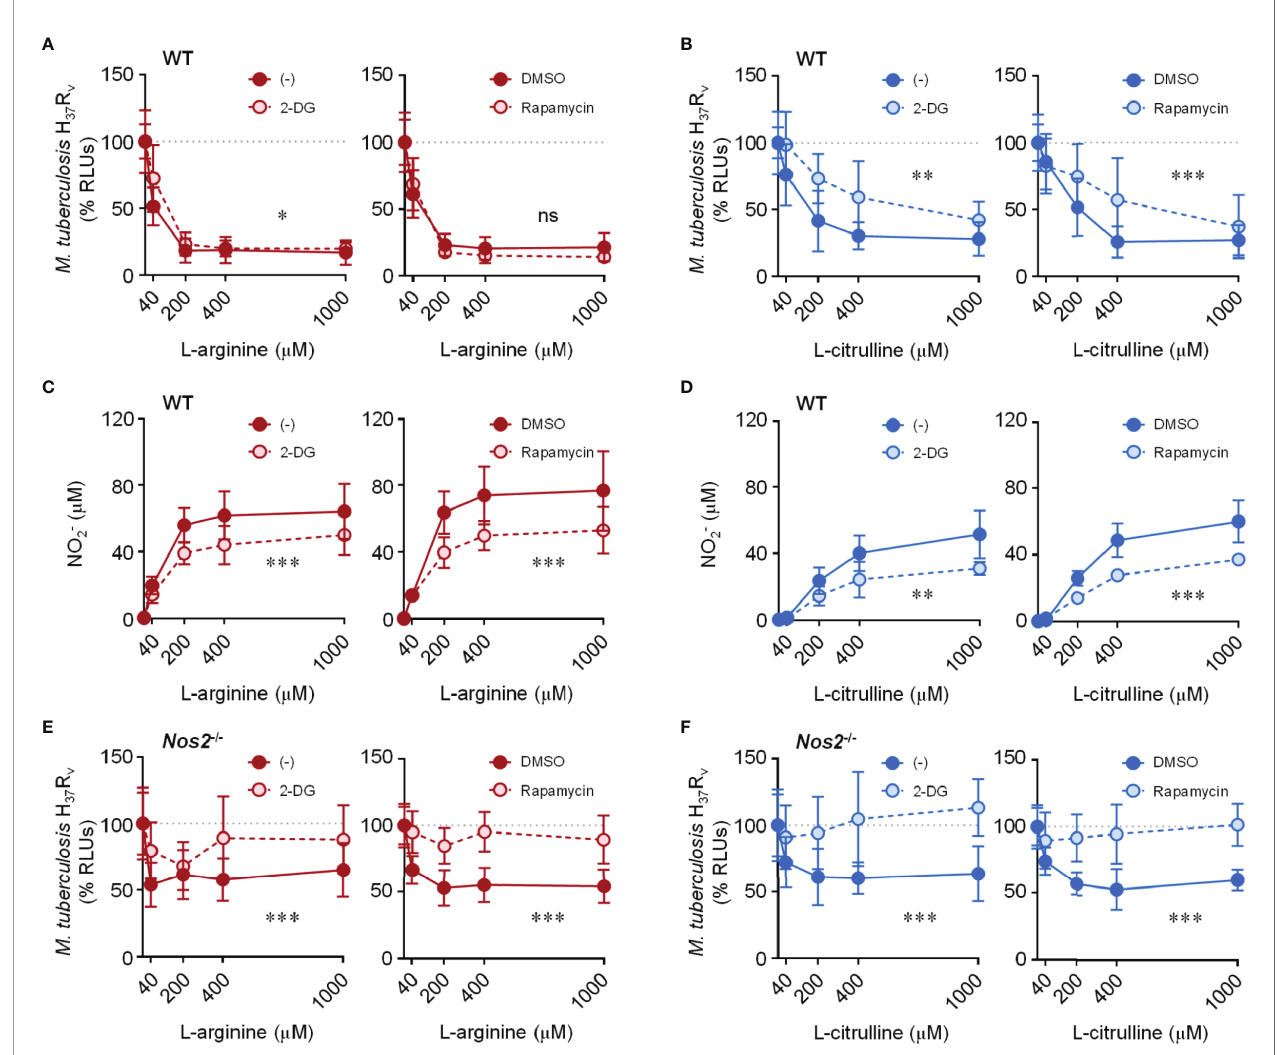
FIGURE 6 | Effect of inhibiting glycolysis and mTORC1 activity on L-arginine/L-citrulline-mediated anti-mycobacterial function. PM F s from C57Bl/6 (WT) or Nos2 -/- mice were infected with Mtb H 37 R v (MOI~1) plus IFN- g cultured in R-free C-DMEM containing titrating amounts of L-arginine (A, C, E) or L-citrulline (B, D, F) with 2- DG (0.1 mM), rapamycin (20 nM), or appropriate controls. 72 hours post-infection Mtb RLUs (A, B, E, F) and NO − 2 production (C, D) were determined as in Figure 1 (N ≥ 6, at least two experiments combined). *p < 0.05, **p < 0.01, ***p < 0.001, by 2-way ANOVA to determine an effect between inhibitor and vehicle control; ns, not signi fi cant. Error bars,